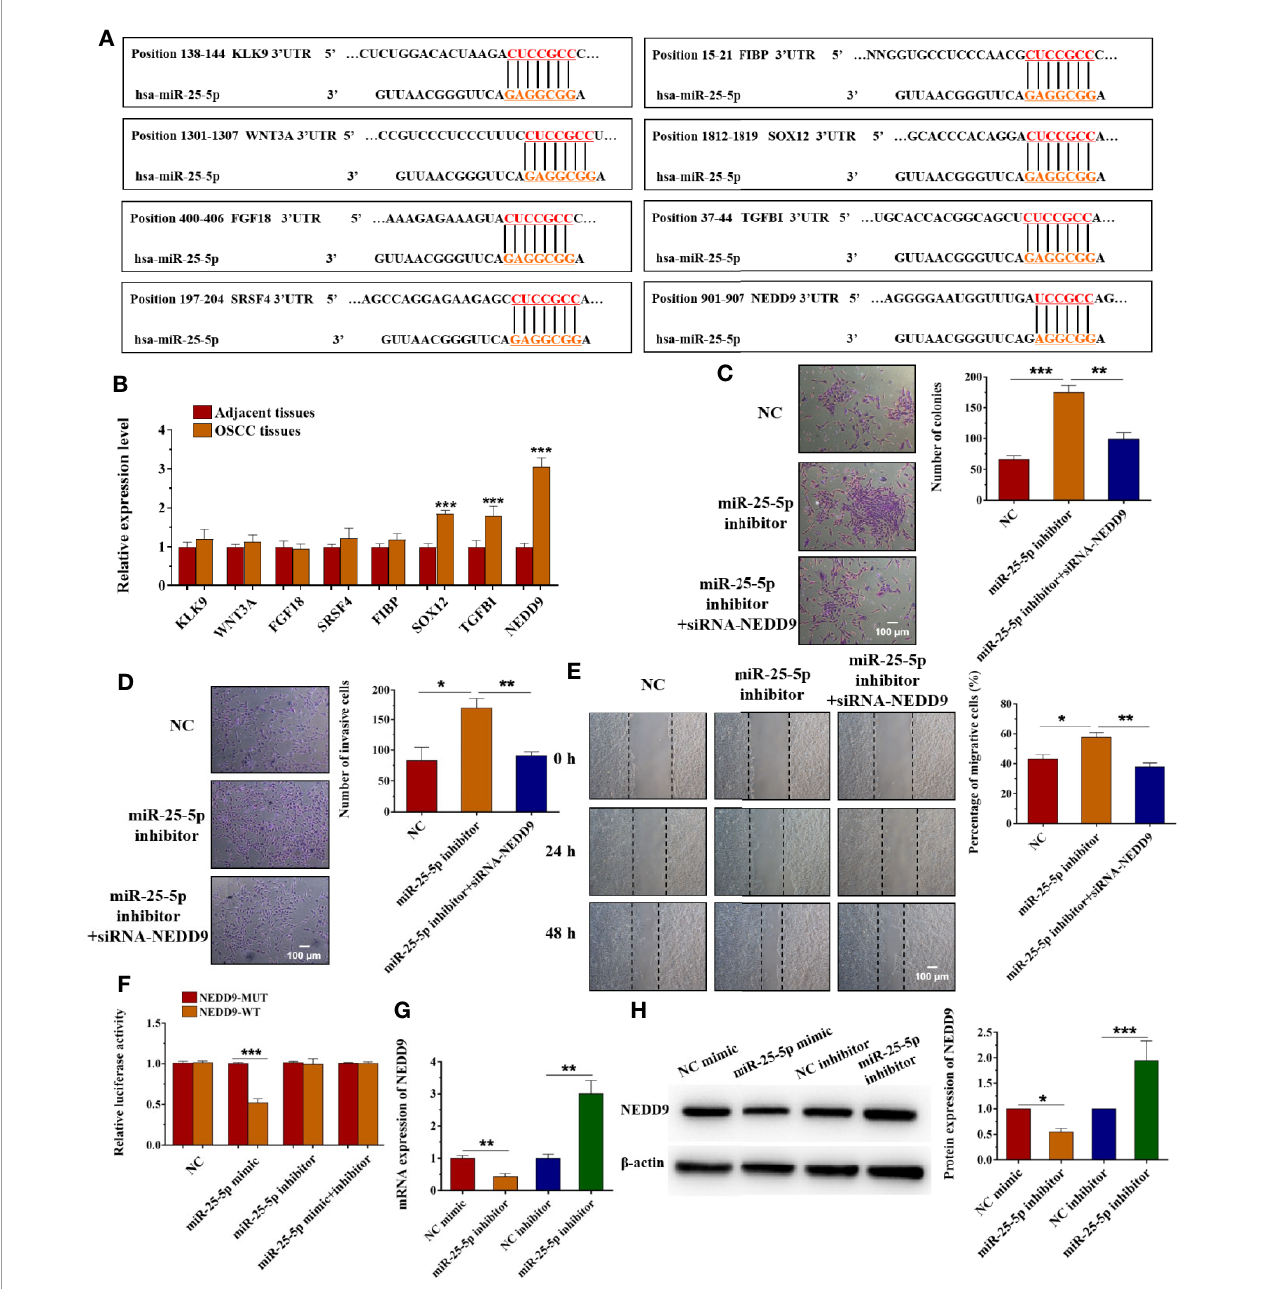
FIGURE 8 | miR-25-5p regulates OSCC cell proliferation, invasion, and migration via targeting NEDD9. (A) Schematic representation of the predicted miR-25-5p binding region in the 3 ′ -UTR of target genes. (B) The expression of KLK9, WNT3A, FGF18, SRSF4, FIBP, SOX12, TGFBI, and NEDD9 in OSCC tissues and adjacent tissues. (C) Colony formation assay was used to examine the proliferation ability. (D) Transwell invasion assay was performed to detect the invasion ability. (E) Wound healing assay was applied to assess the migration ability. (F) Luciferase activity was analyzed to con fi rm the relationship between miR-25-5p and NEDD9. (G, H) RT-qPCR (G) and western blotting (H) were performed to examine the NEDD9 level in SCC9 cells transfected with miR-25-5p mimic or NC mimic. (n=4, B: Student ’ s t-test; C-H: One way ANOVA followed by the Tukey ’ s test, * indicated the differences compared with NC mimics/inhibitor group, *p < 0.05, **p < 0.01, ***p < 0.001, Scale bar, 100 m